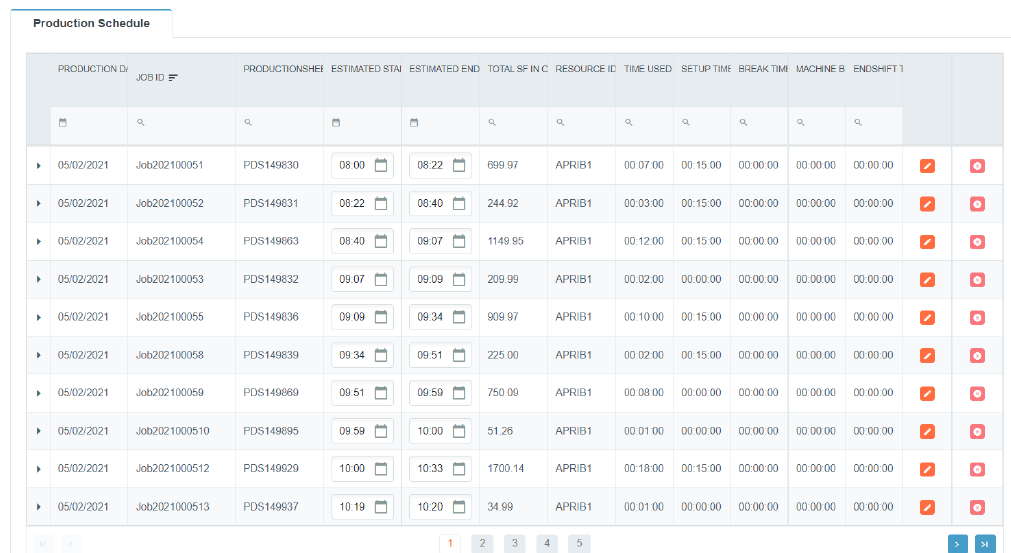
Figure 11. The performance of the total setup times for each machine.